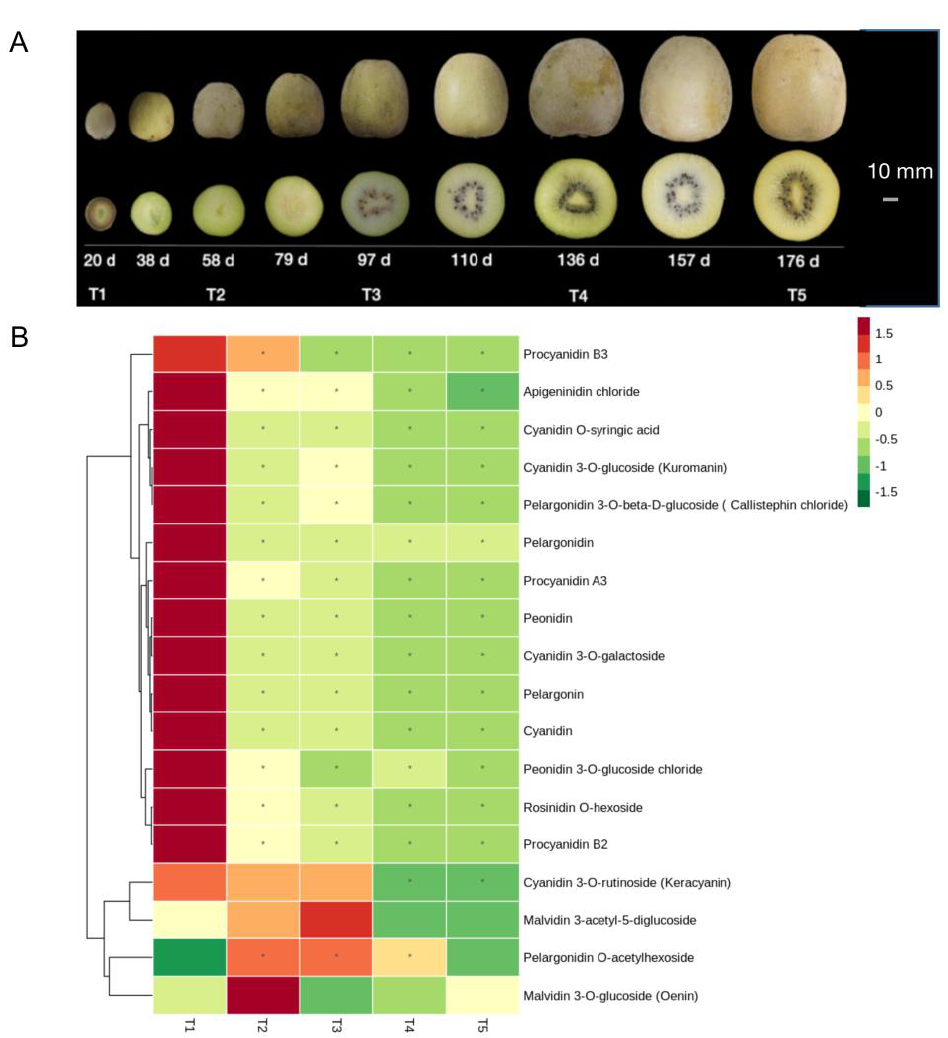
Figure 1. ( A ): Morphological changes in nine developmental stages. ( B ): Cluster heat map of relative content of anthocyanin and procyanidins. Each line in the heatmap represents a metabolite. The deeper the red color, the higher the level of that metabolite in developing fruits. Similarly, the deeper the green color, the lower the level of that metabolite in developing fruits. The five cells from left to right represent samples of 20 d − 176 d. The symbols (*) in the figure represent significance.